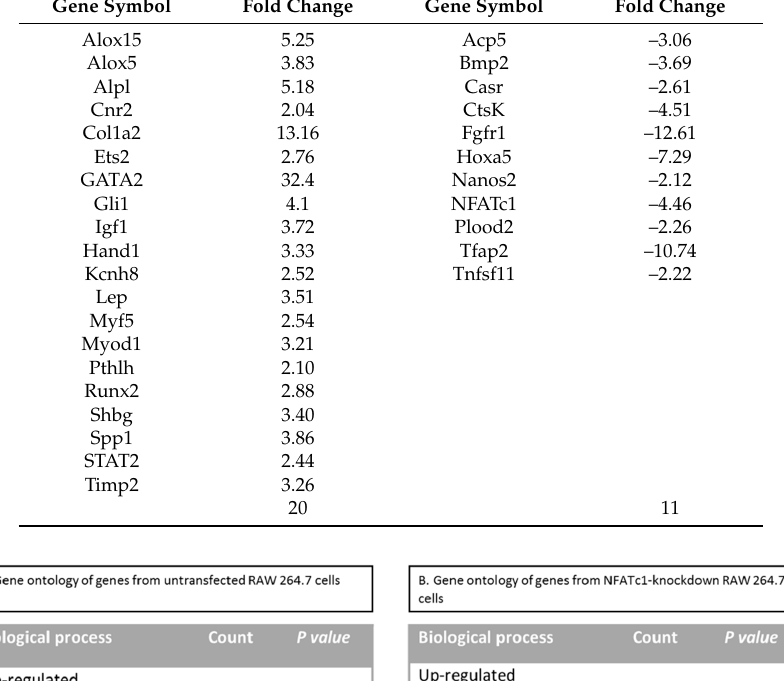
Table 2. List of genes from NFATc1-knockdown RAW 264.7 cells (genes ≥ 2-fold).